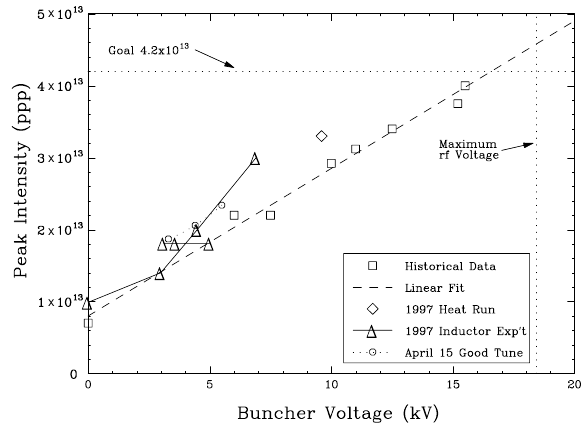
FIG. 5. Stability threshold versus rf-voltage improvement. Results of this experiment are depicted by